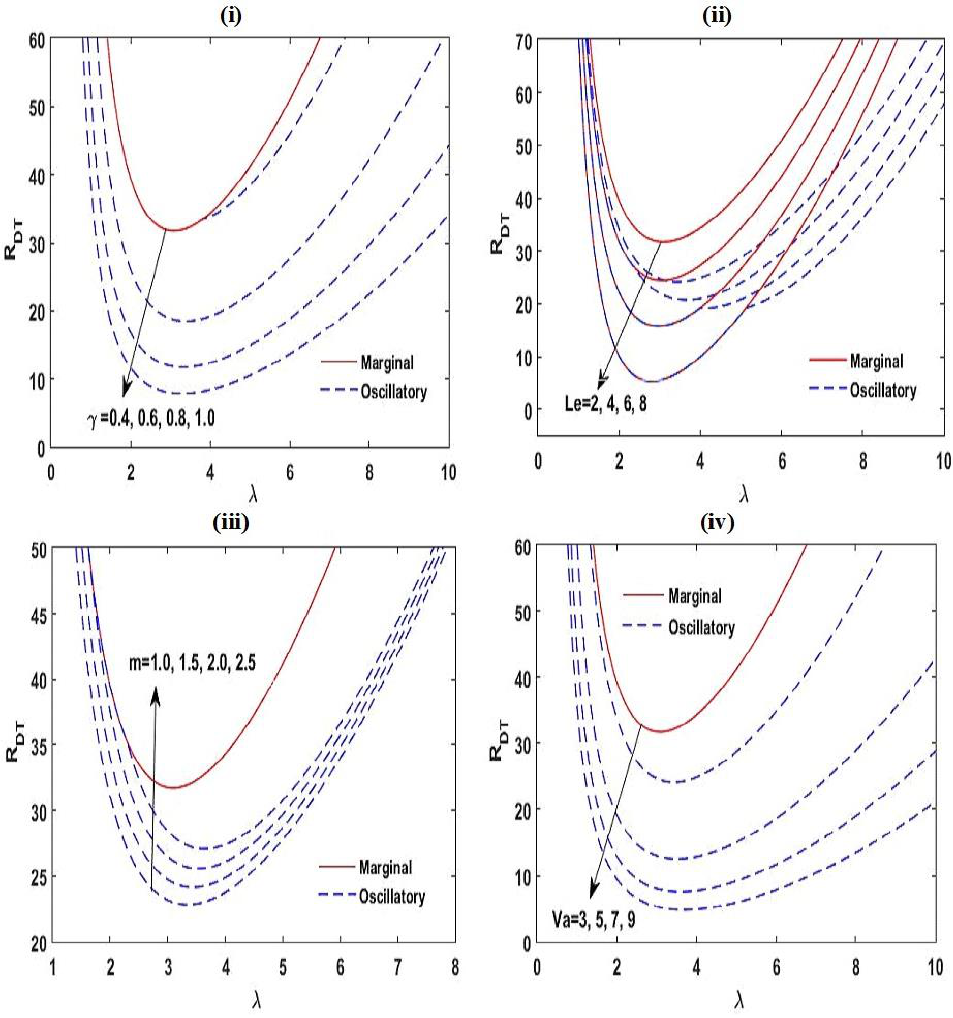
Figure 4. The effect of γ , Le , m , and Va on the neutral stability curves at Le = 2, γ = 0.5, m = 1.5, A = 1, R DS = 3, S N = 0.5, K RN = 0.5, and Va = 3 with variation in one of these parameters.